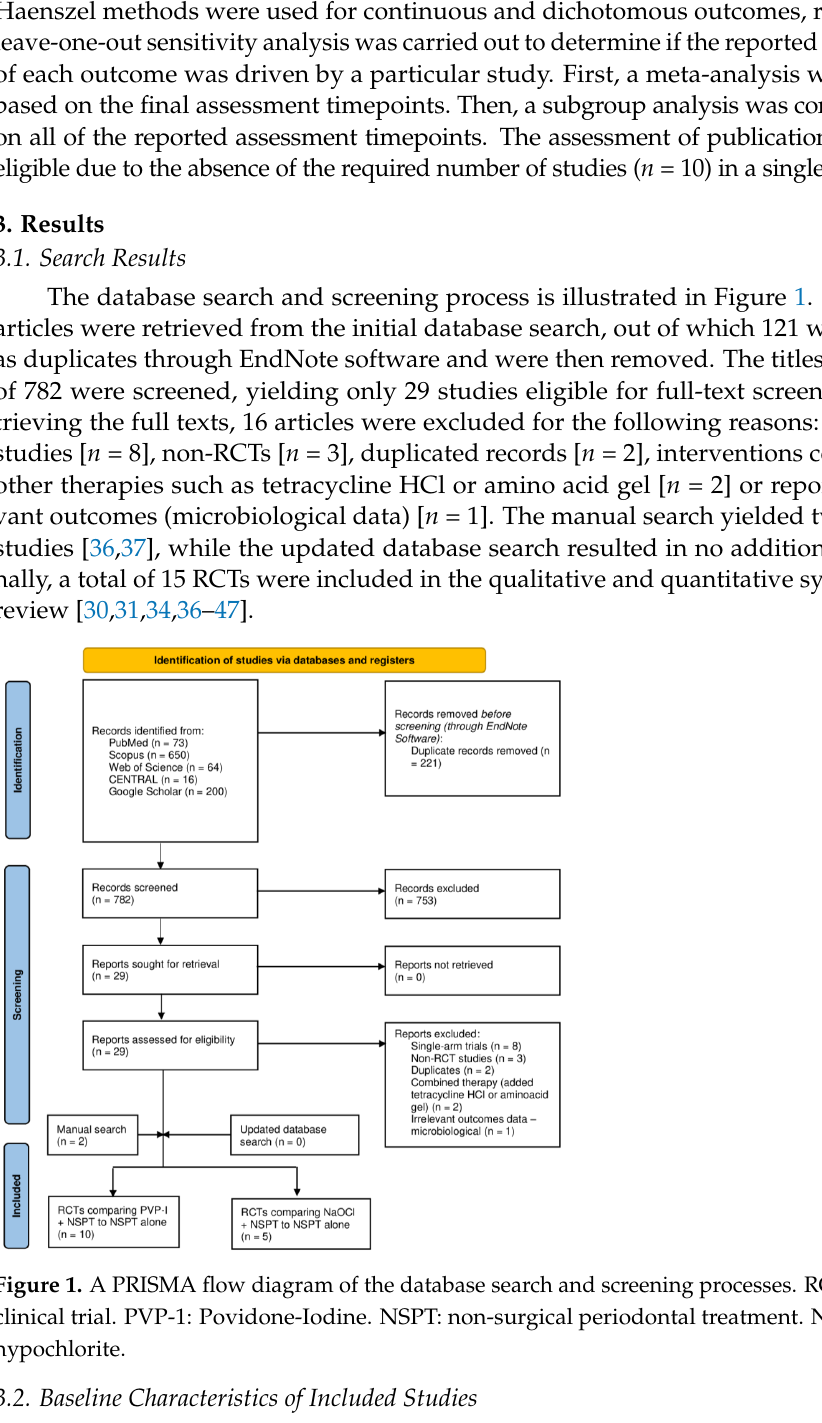
Table 1. Baseline characteristics of included studies reporting the use of PVP-I or NaOCl as an ad- juvant to non-surgical debridement in periodontitis ( n = 14). Author Sample (YOP) Country Design ( n )